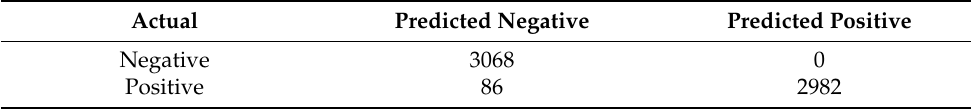
Table 13. Confusion matrix for J48 DT model